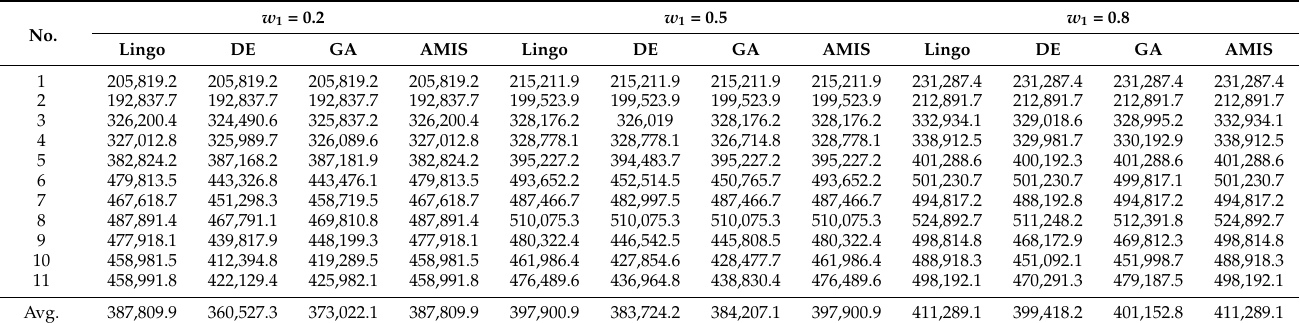
Table 15. Average profit per container using different weights w 1